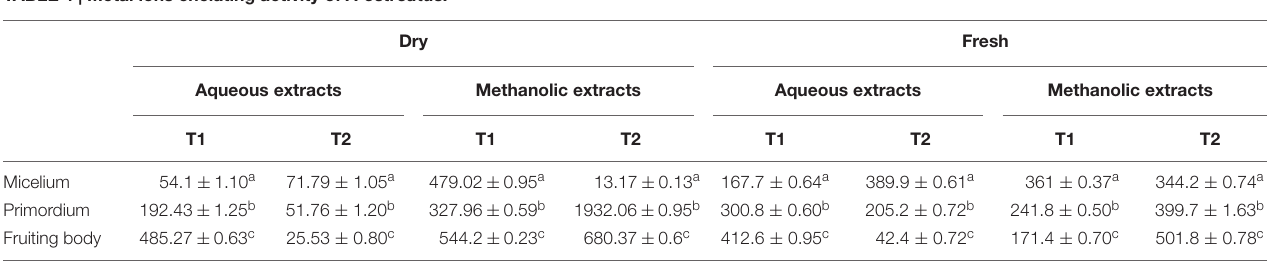
TABLE 4 | Metal ions chelating activity of P.